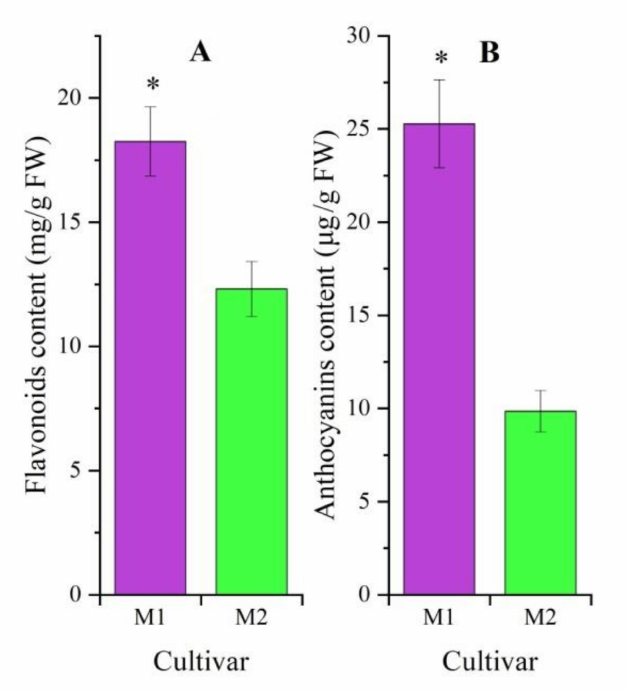
Figure 1. Contents of flavonoids ( A ) and anthocyanins ( B ) in Mingui 1 (M1) and Mingui 2 (M2) (mean ± SD, n = 3). A t -test was performed for independent treatments, and the “*” is considered significant at p < 0.05 between M1 and